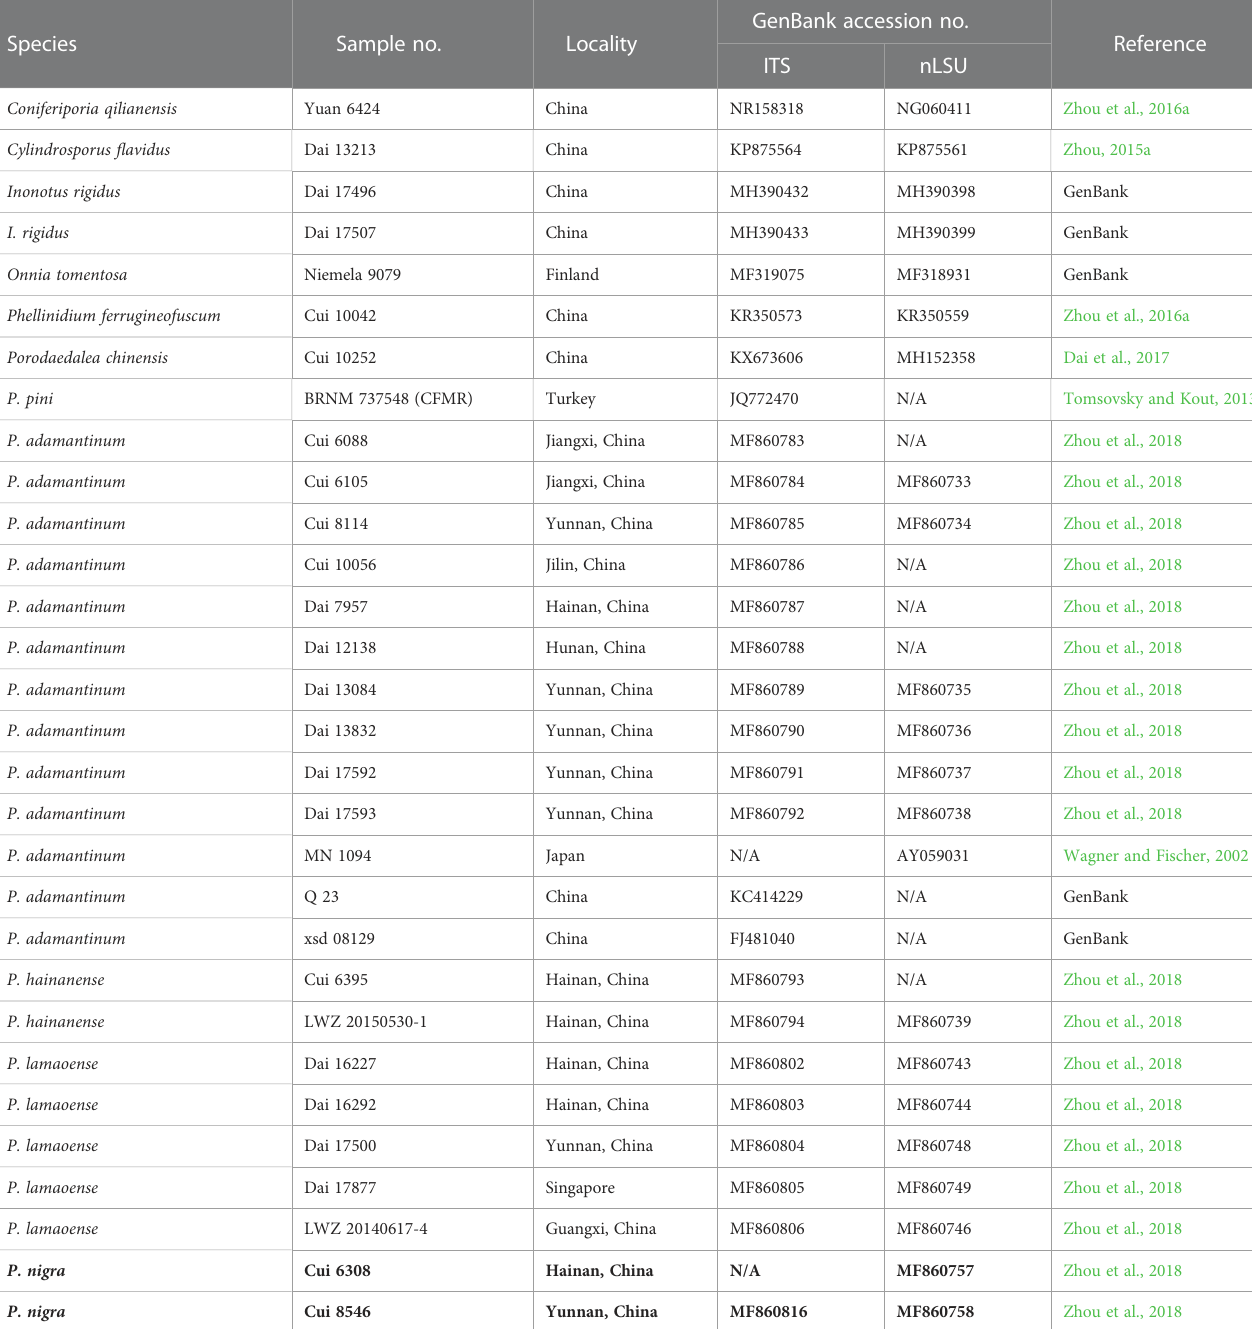
Species Sample no.